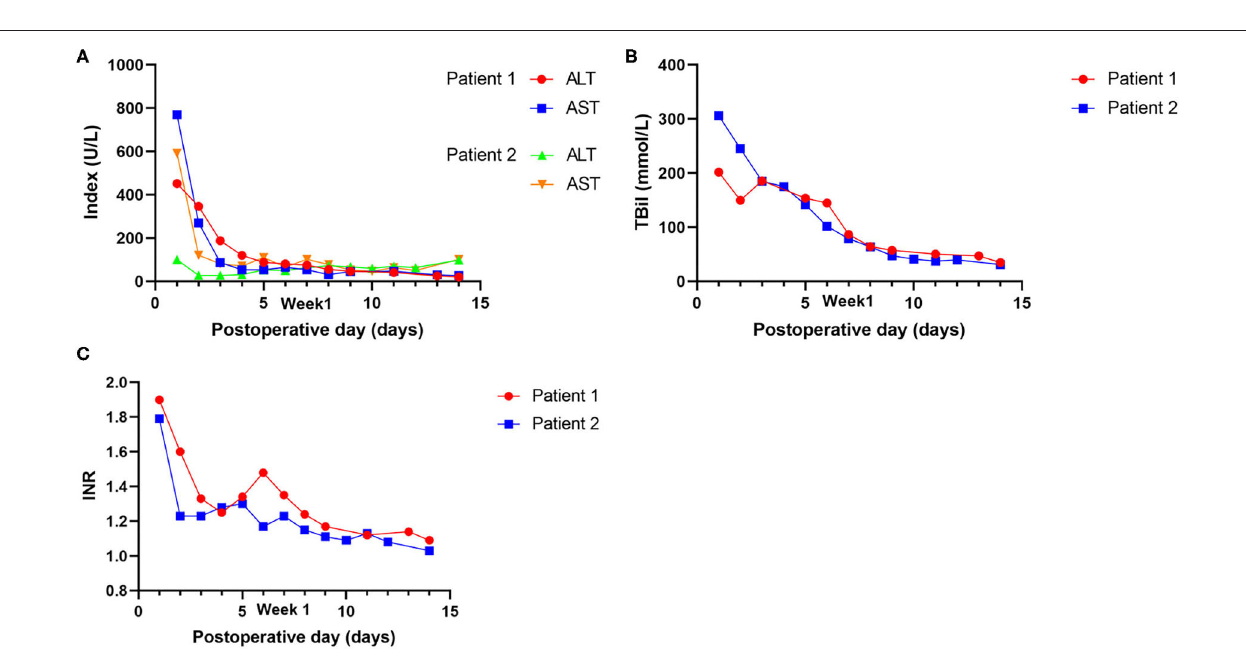
Frontiers in Surgery |